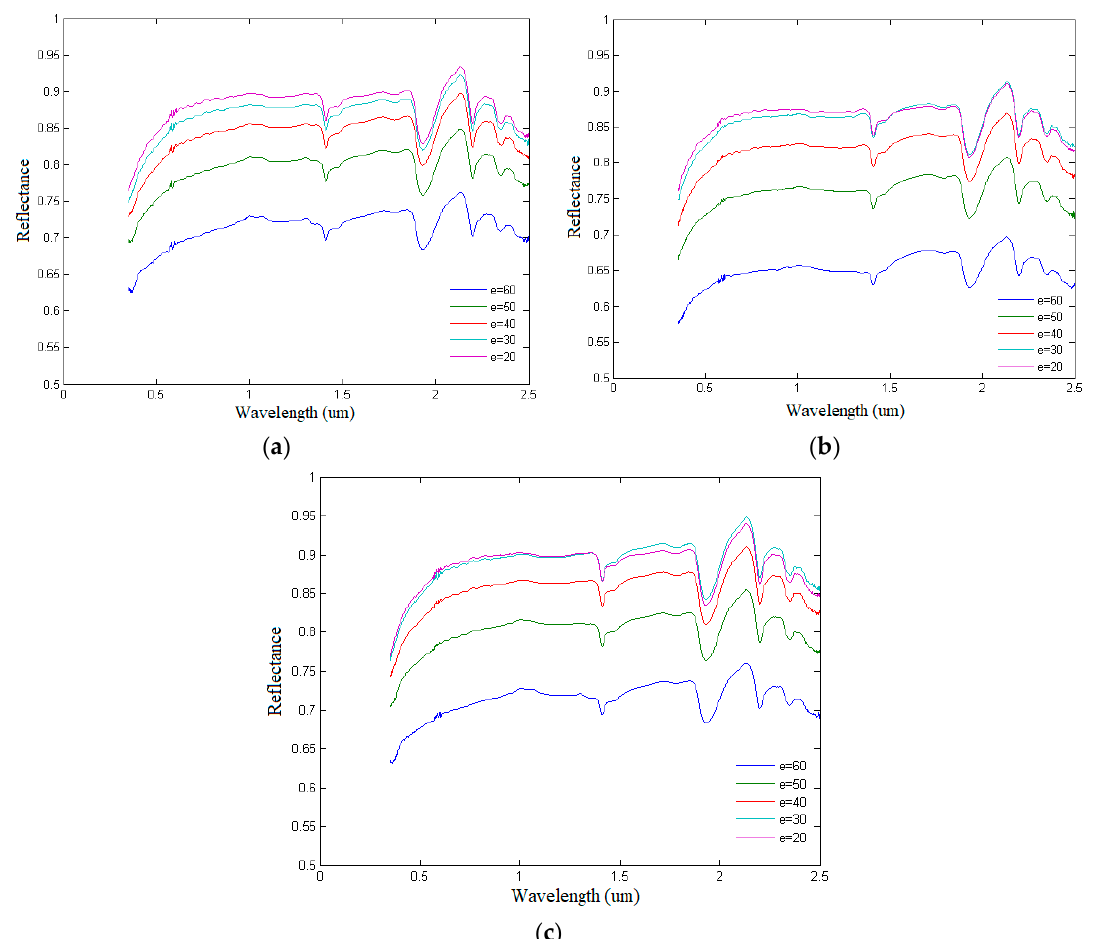
Figure 5. Measured multi-angle spectral data of plagioclase (i, e and φ are the incidence angle, emittance angle and azimuth angle, respectively) including five multi-angle spectra at an incident angle of 0° and azimuth angle of 180° ( a ); five multi-angle spectra at an incident angle of 0° and azimuth angle of 210° ( b ); and five multi-angle spectra at an incident angle of 0° and azimuth angle of 240° ( c ).